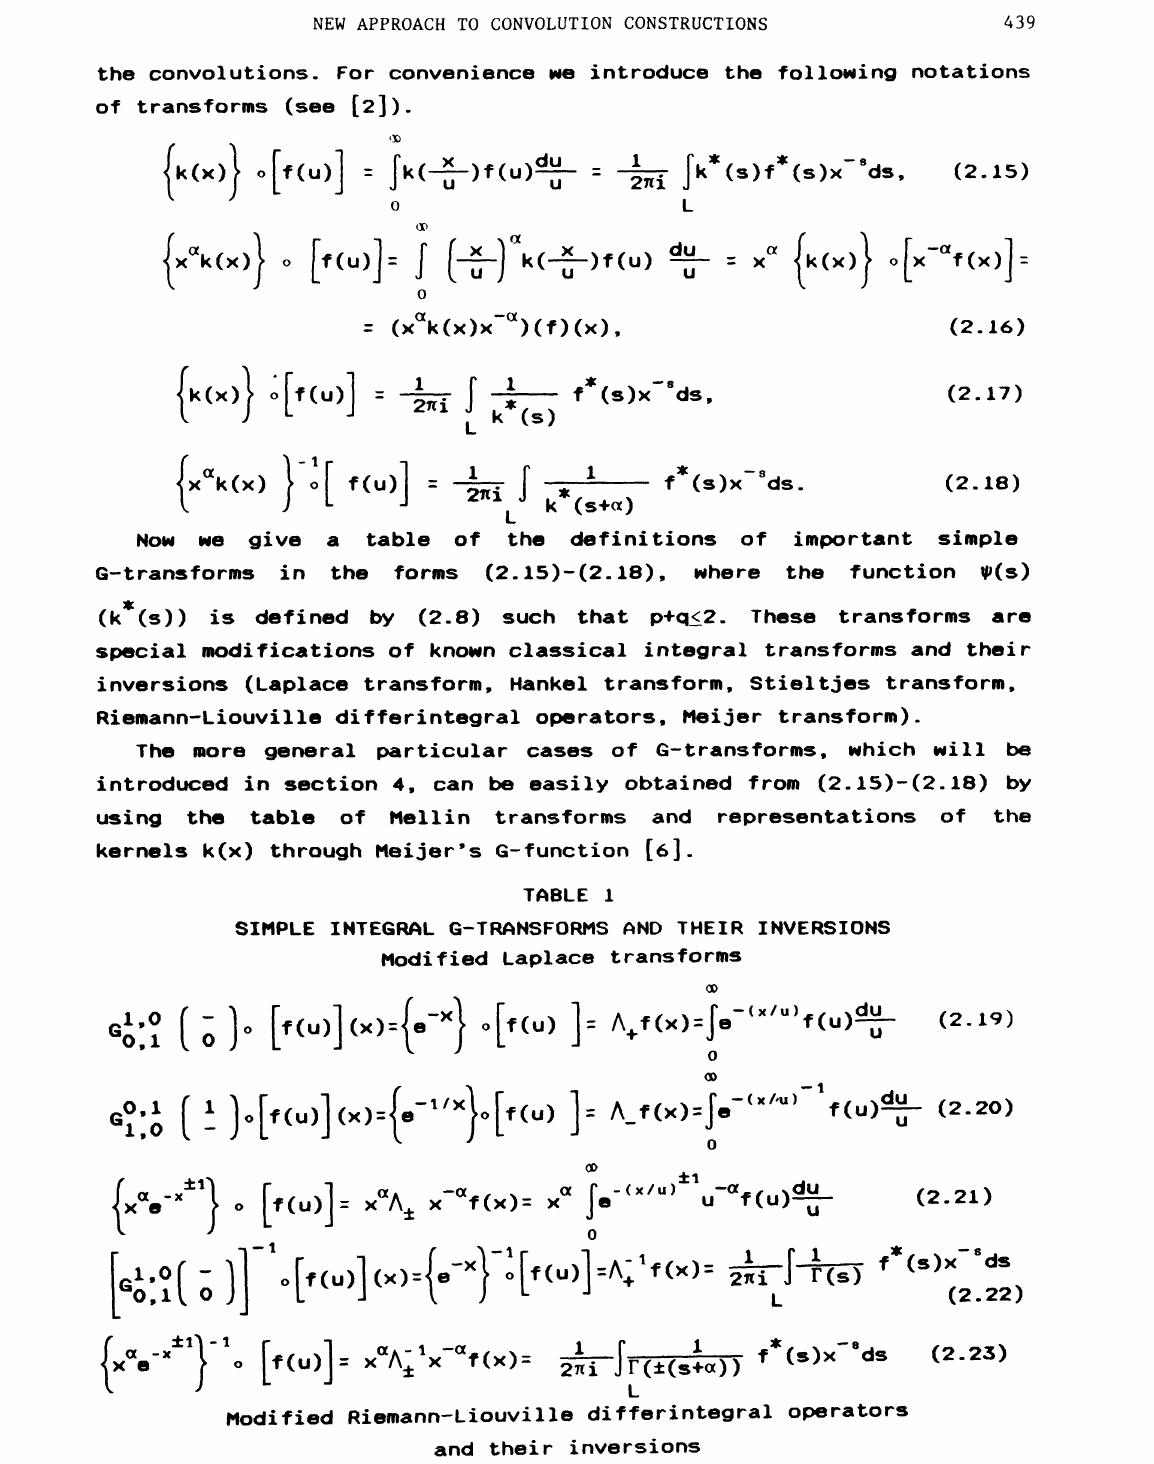
SIMPLE ZNTEGRL G-TRNSFORHS AND THEIR INVERSIONS Hodified Laplace